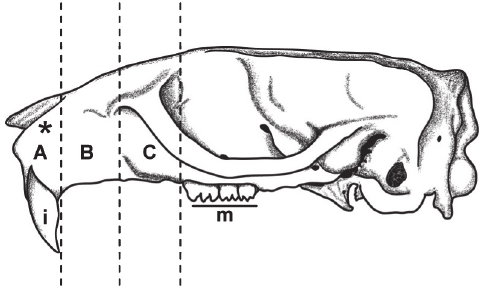
Fig. 1. – The three maxillar regions delineated for histology, shown on a rodent skull in lateral view. A, from the vestibulum to the beginning of incisor (i); B, incisor tooth region; C, from the posterior part of the incisor to the first molar (m). * indicates the position of adult Trichosomoides nasalis .